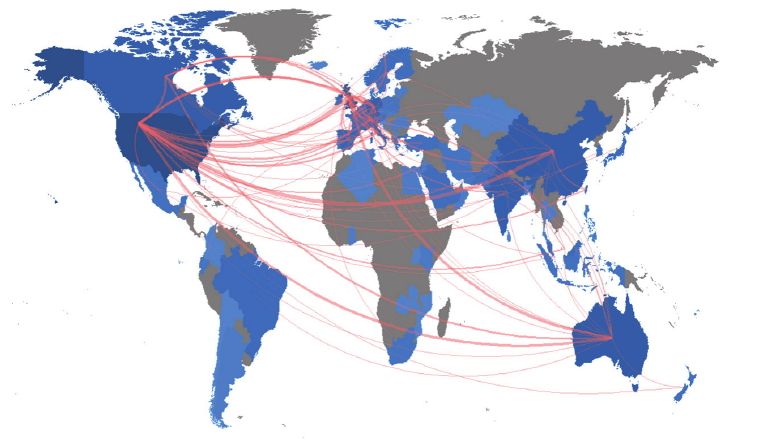
Fig. 13. Country collaboration